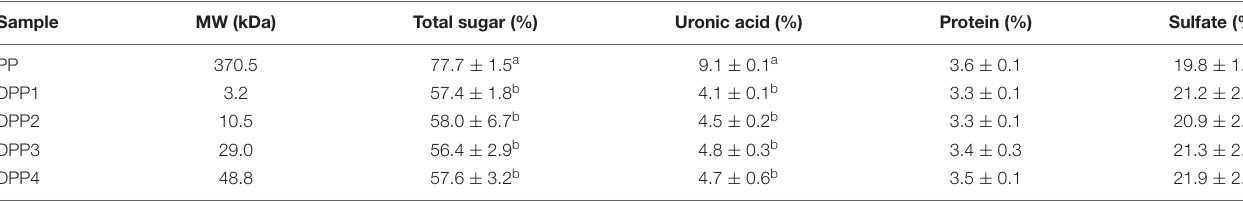
Values are mean ± SD of three replicates. Different letters indicate significant differences at P <